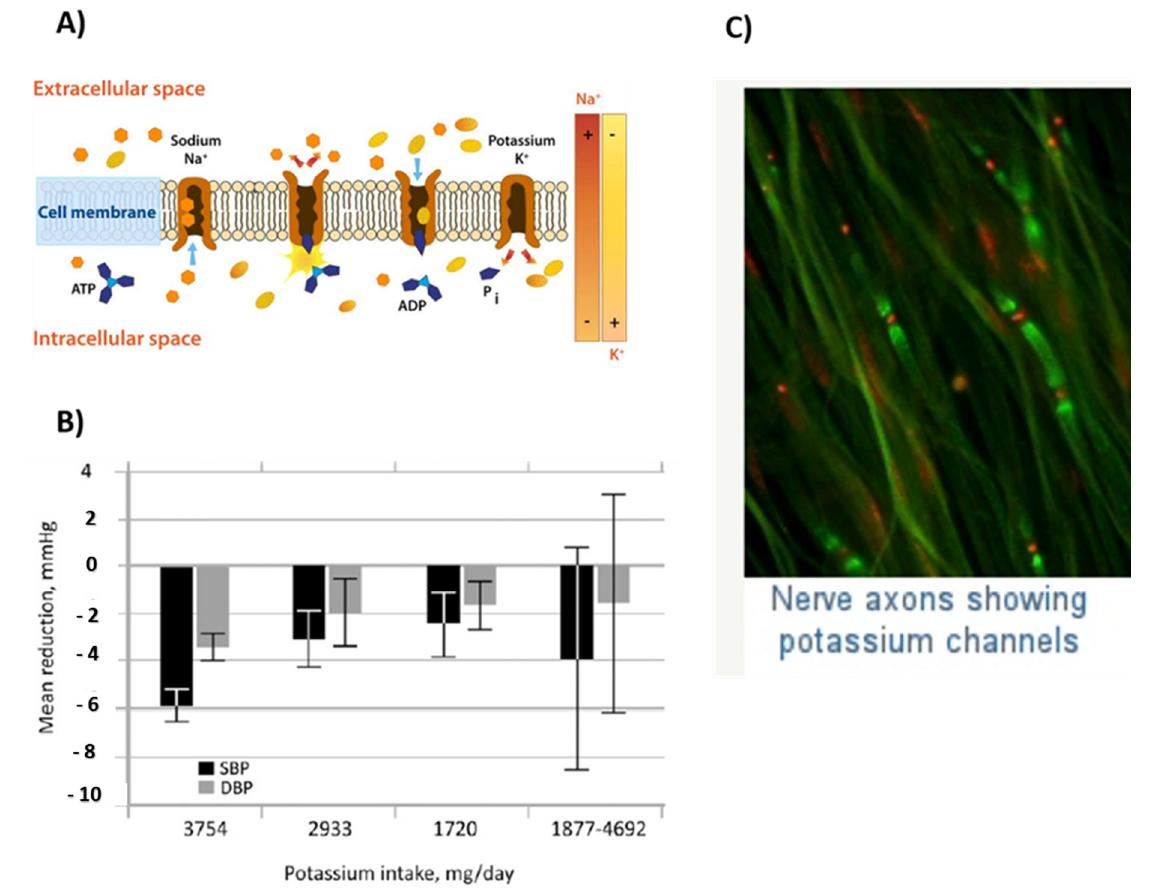
Figure 9. ( A ) shows a sodium–potassium pump, and ( B ) shows the lowering of systolic and diastolic blood pressure by 5.9 and 3, 4mmHg, respectively, due to the potassium intake. Adapted from [138]. Reproduced with permission from American Society for Nutrition. ( C ) shows nerve axons having channels of potassium. Adapted from [139]. Reproduced with permission from American Society for Nutrition.